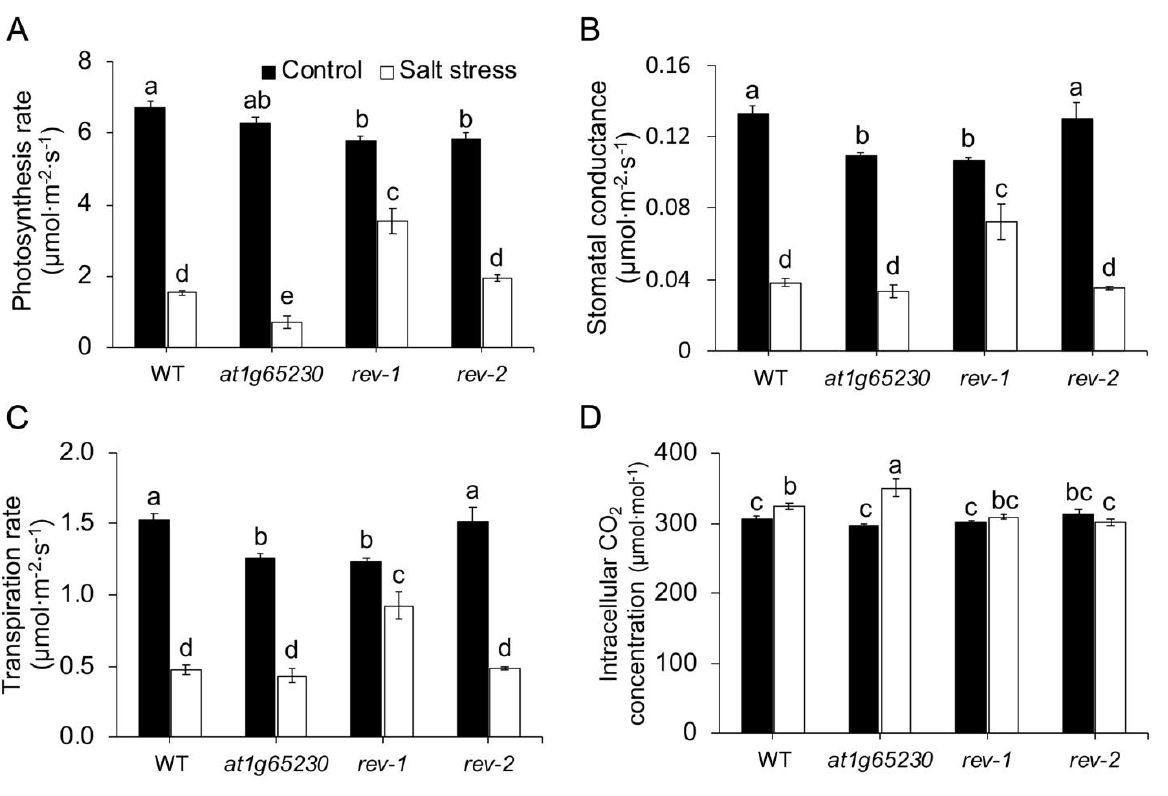
Figure 3. Photosynthetic parameters of the Arabidopsis wildtype (WT), at1g65230 mutant, and revertant line ( rev − 1 and rev − 2 ) cultured under control (black bars) and salt − stress (white bars) conditions. Photosynthetic rate ( P n ) ( A ), stomatal conductance ( g s ) ( B ), transpiration rate ( E ) ( C ), and intracellular CO 2 concentration ( C i ) ( D ) were determined after 10 days of treatments. The different letters above the bars represent the significant difference among means ( p < 0.05). Error bars show the standard error of 3 replicates.